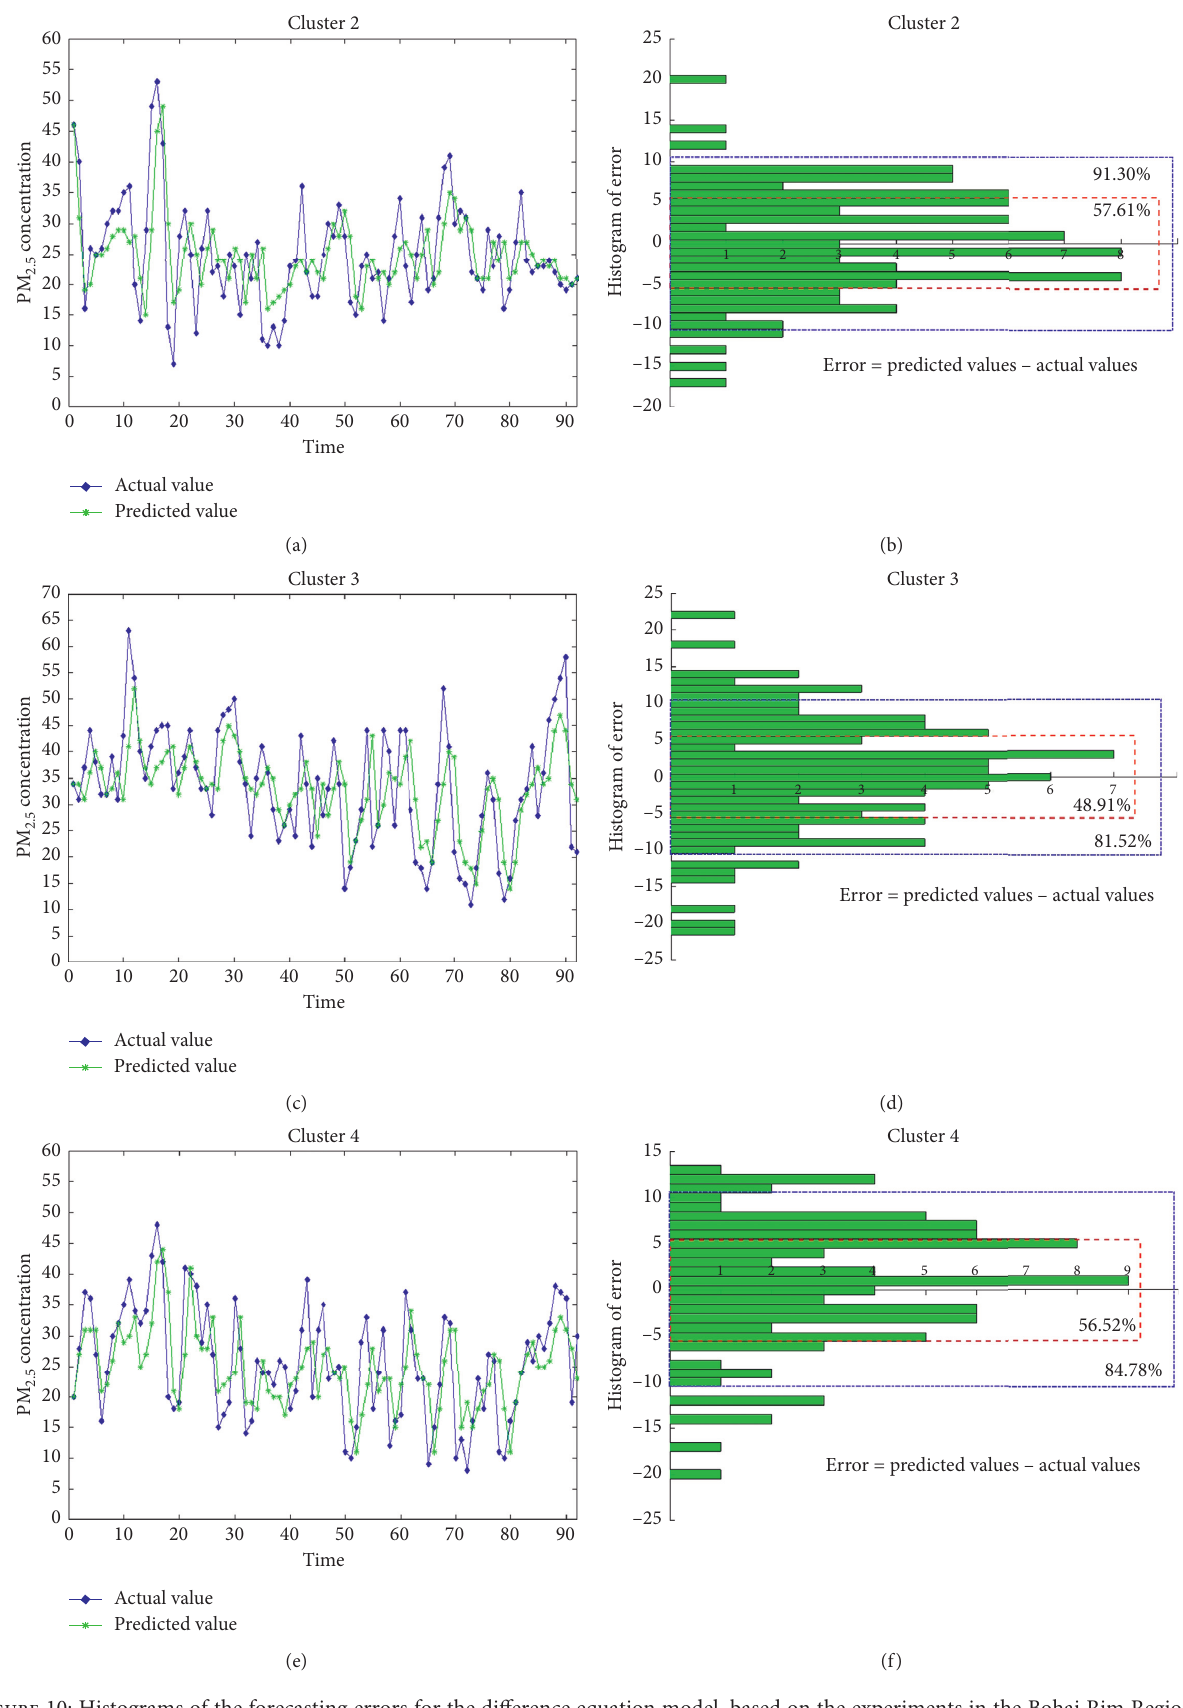
Figure 10: Histograms of the forecasting errors for the difference equation model, based on the experiments in the Bohai Rim Region of China. The red box indicates the amount of prediction error between 5 units. The blue box indicates the amount of prediction error between 10